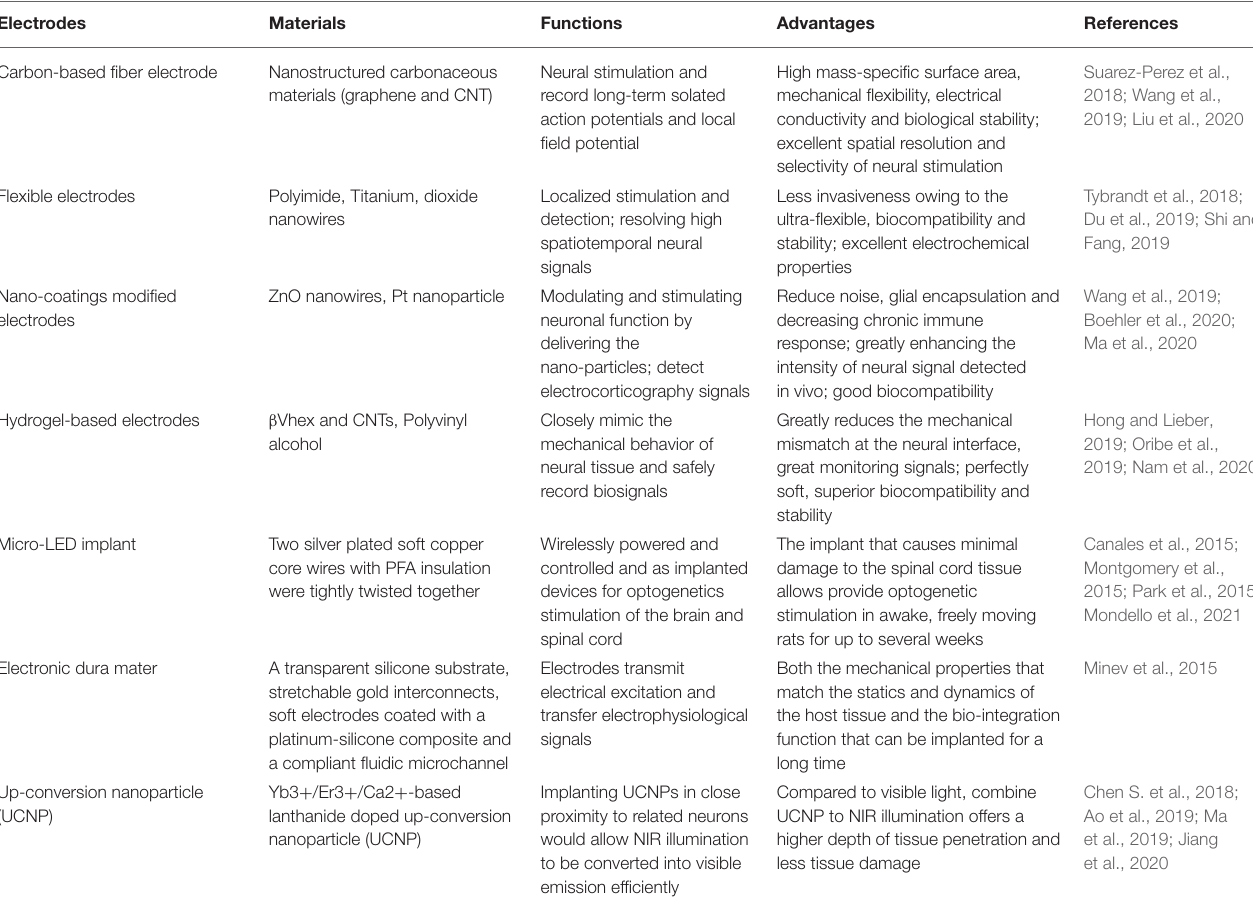
TABLE 1 | Novel electrodes for electrical/optical stimulation and electrical signal